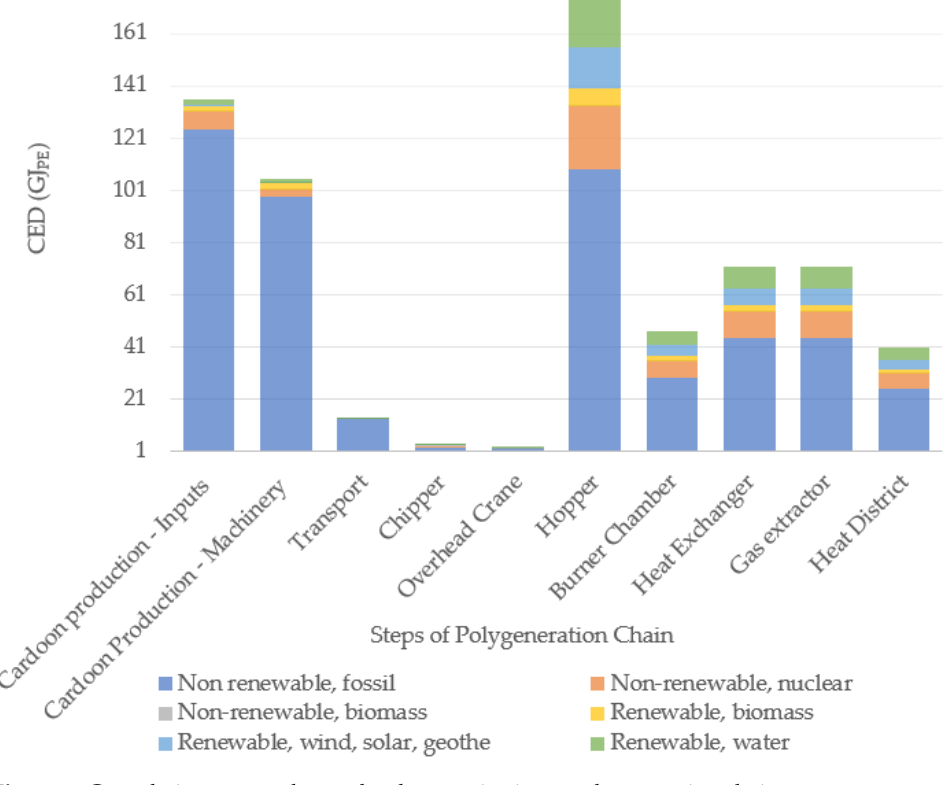
Figure 3. Cumulative energy demand — characterisation — polygeneration chain.